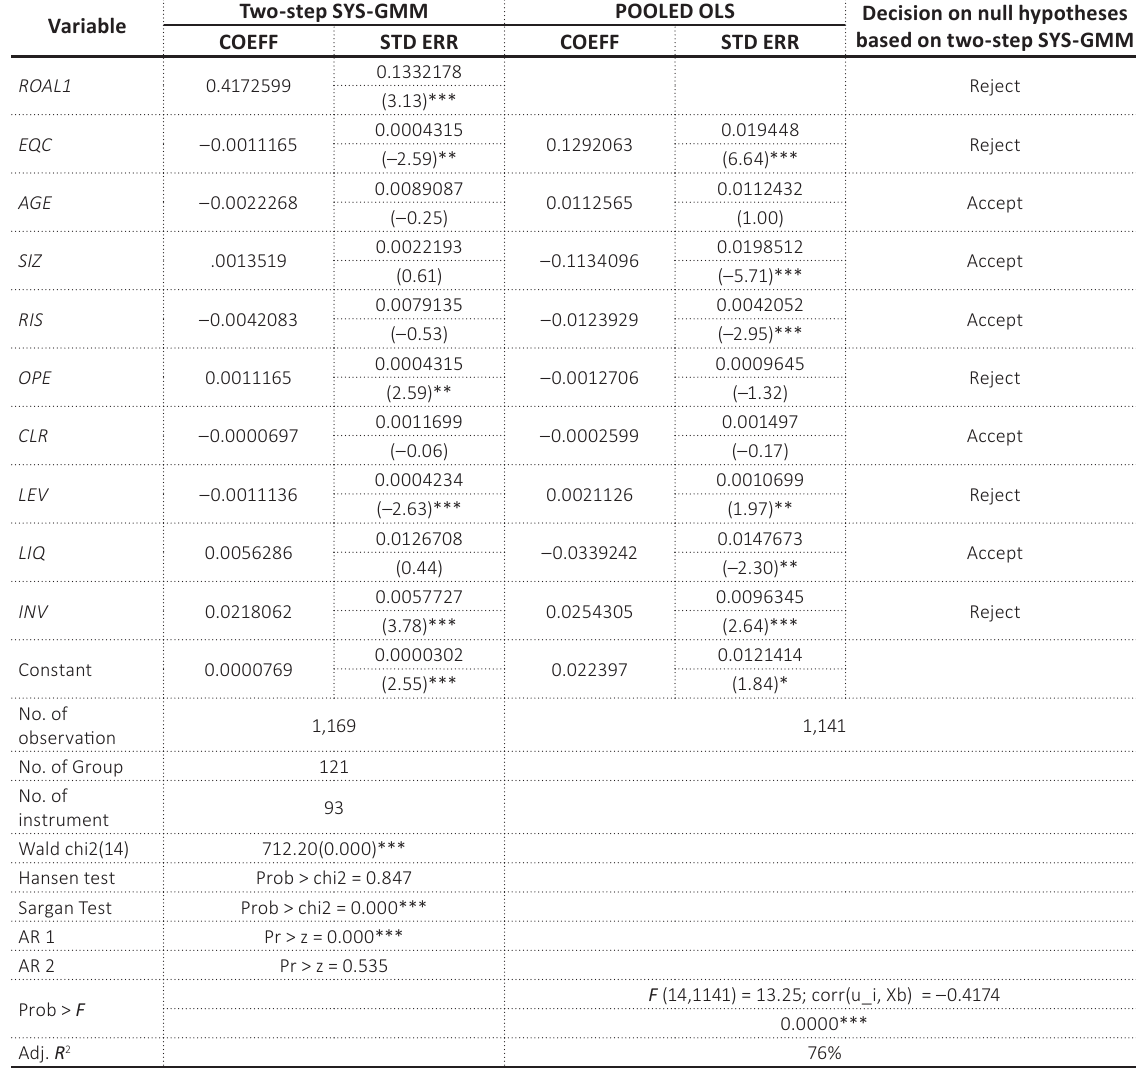
Table 4. Regression analysis: OLS and two-step SYS-GMM